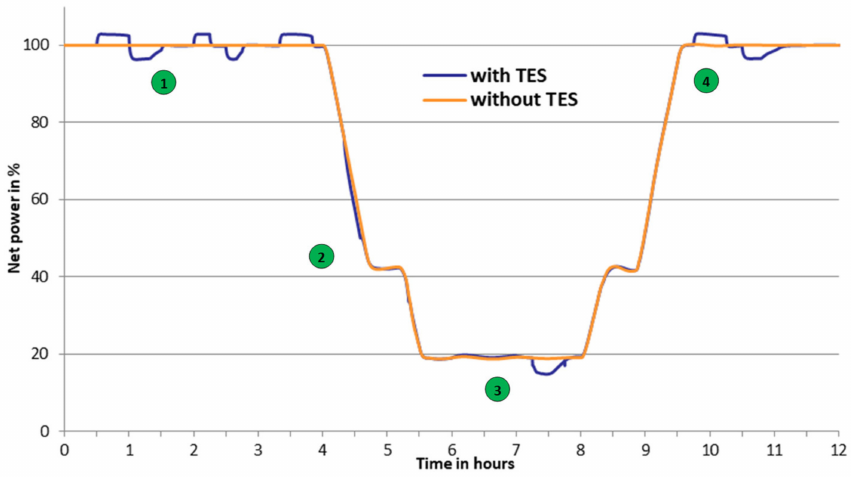
Figure 6. Course of net power over the entire simulation period (CRH/LS-HPPH7_directly